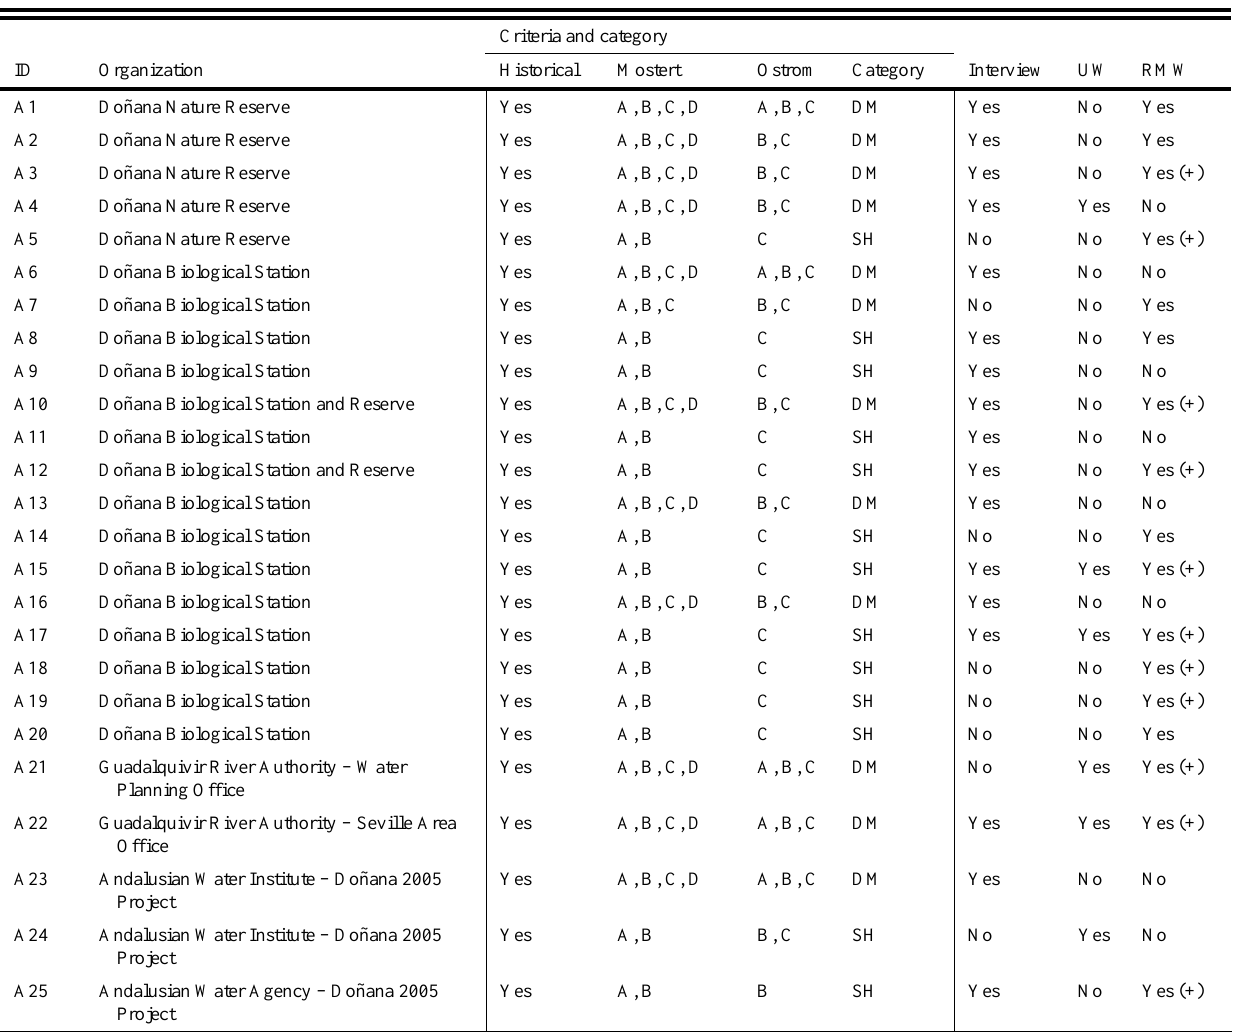
Table A2.2 . Identified actors (UW = uncertainty workshop, RMW = research-management workshop, DM = decision maker, SH =